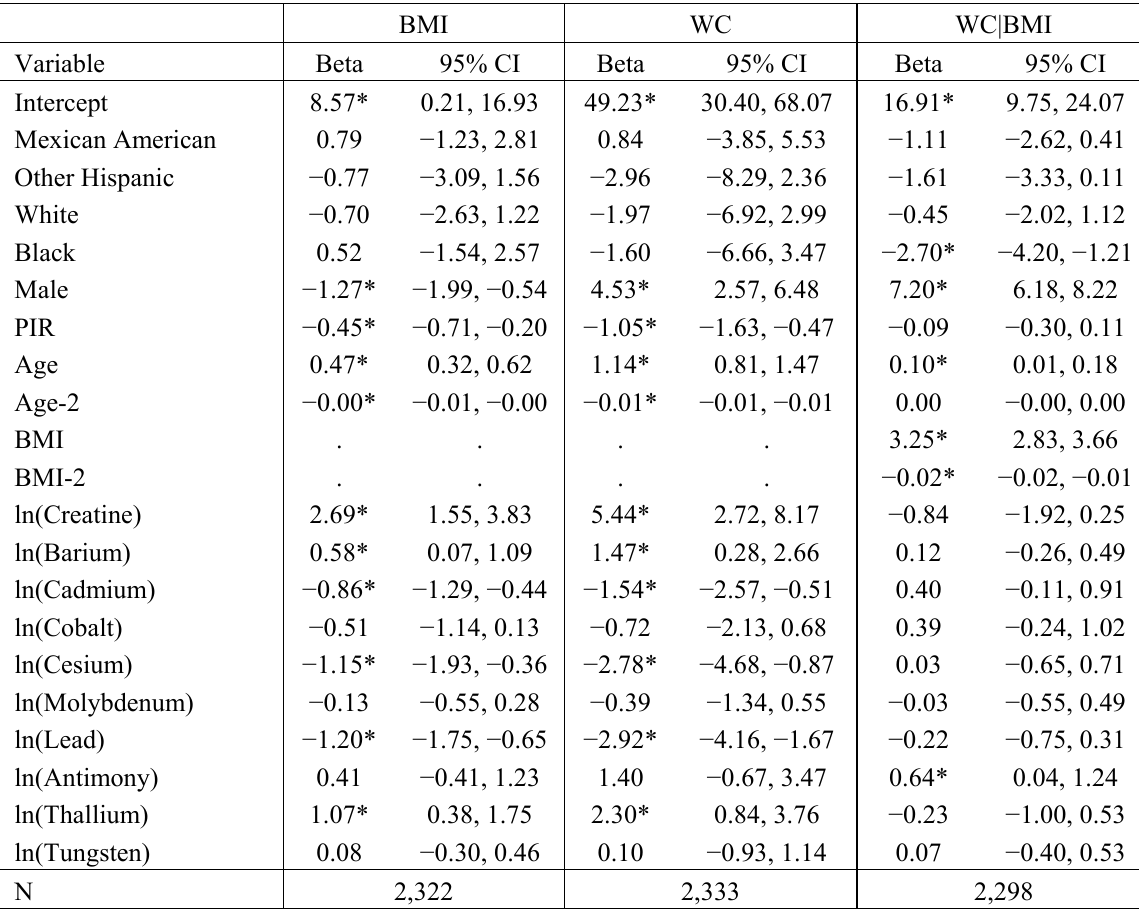
Table 12. Regression Models for